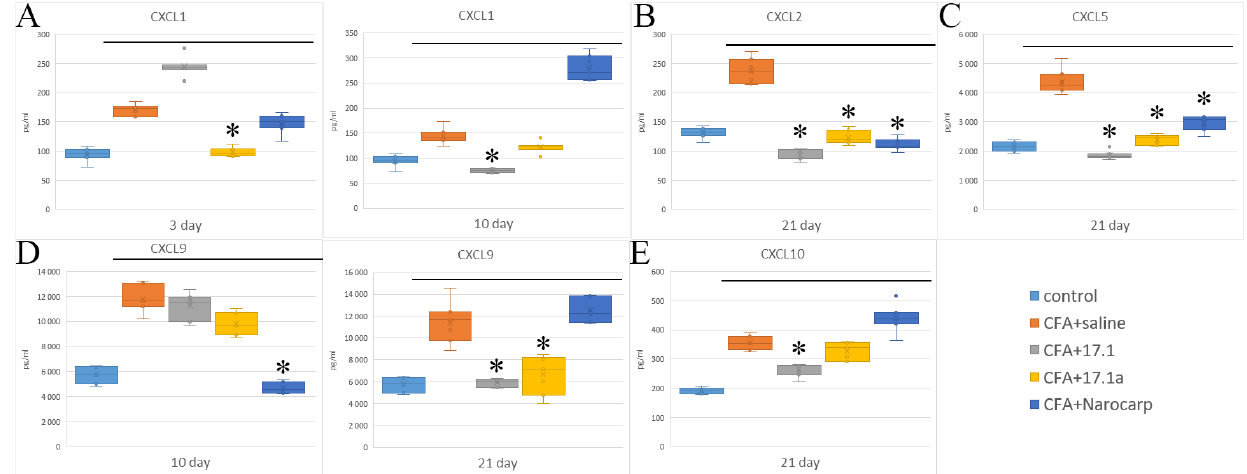
Figure 2. Changes in the level of chemokines (( A ) CXCL1; ( B ) CXCL2; ( C ) CXCL5; ( D ) CXCL9; ( E ) CXCL10) in the plasma of mice after CFA-induced arthritis. (Control — control animals without CFA injection, CFA — animals with induced via CFA arthritis, +saline — animals were treated by phosphate buffered saline (PBS), +17.1a, +17.1, +Norocarp — animals were treated by a specified agent, n = 7 for each group). ( p -value: * < 0.05).